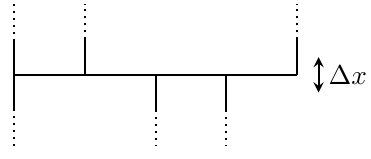
Figure 2: A maximal segment of an